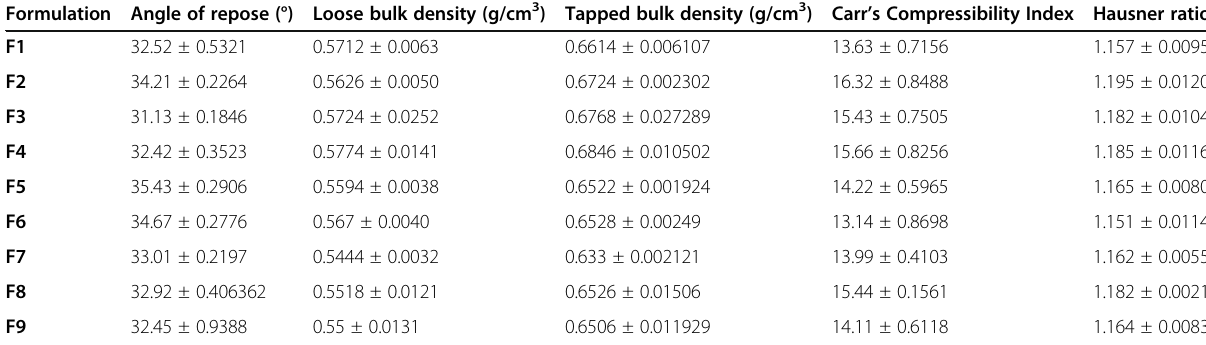
Table 6 Pre-compression study data